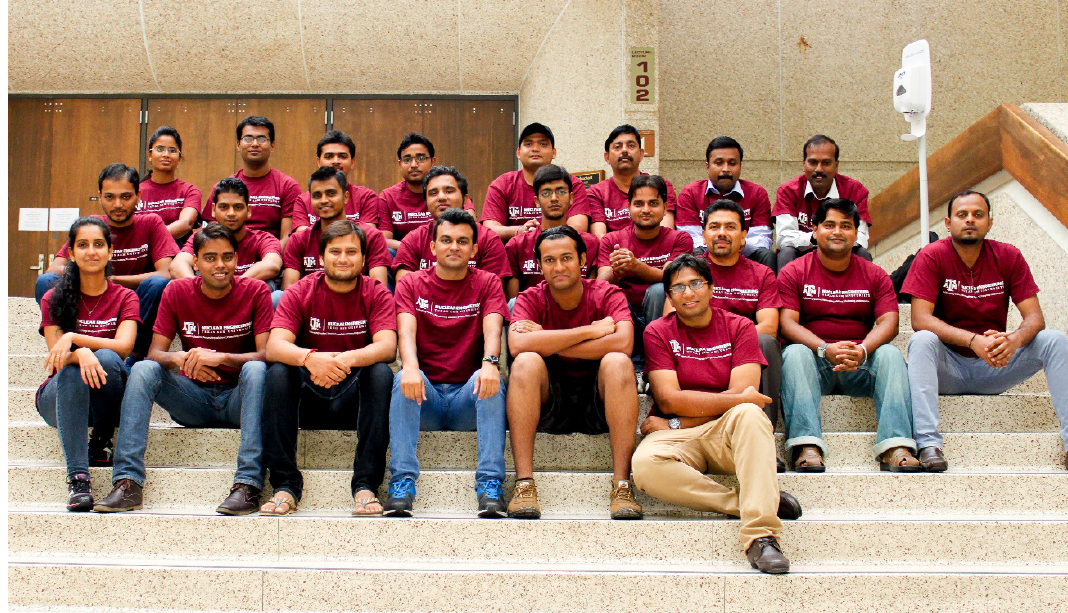
Figure 6. Students and faculty from Indian Universities during the Nuclear Security Training Series at Texas A&M in the summer of